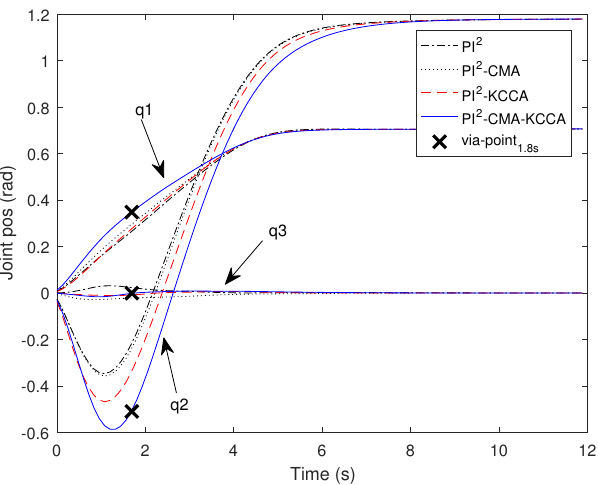
Figure 3. One via-point task when the number of iterations is 30.